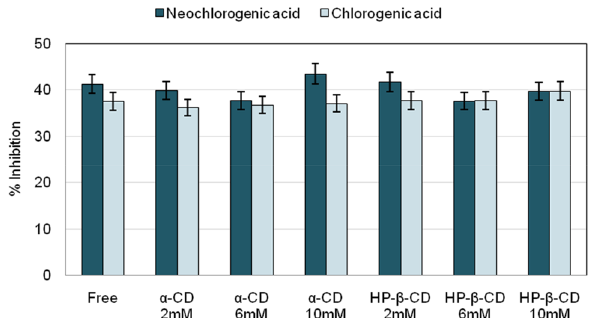
Figure 6. Antioxidant activity of neochlorogenic acid and chlorogenic acid, in free forms and encapsulated in α-CD and HP-β-CD. Ethanol was used as a negative control. T-test (significance of p <